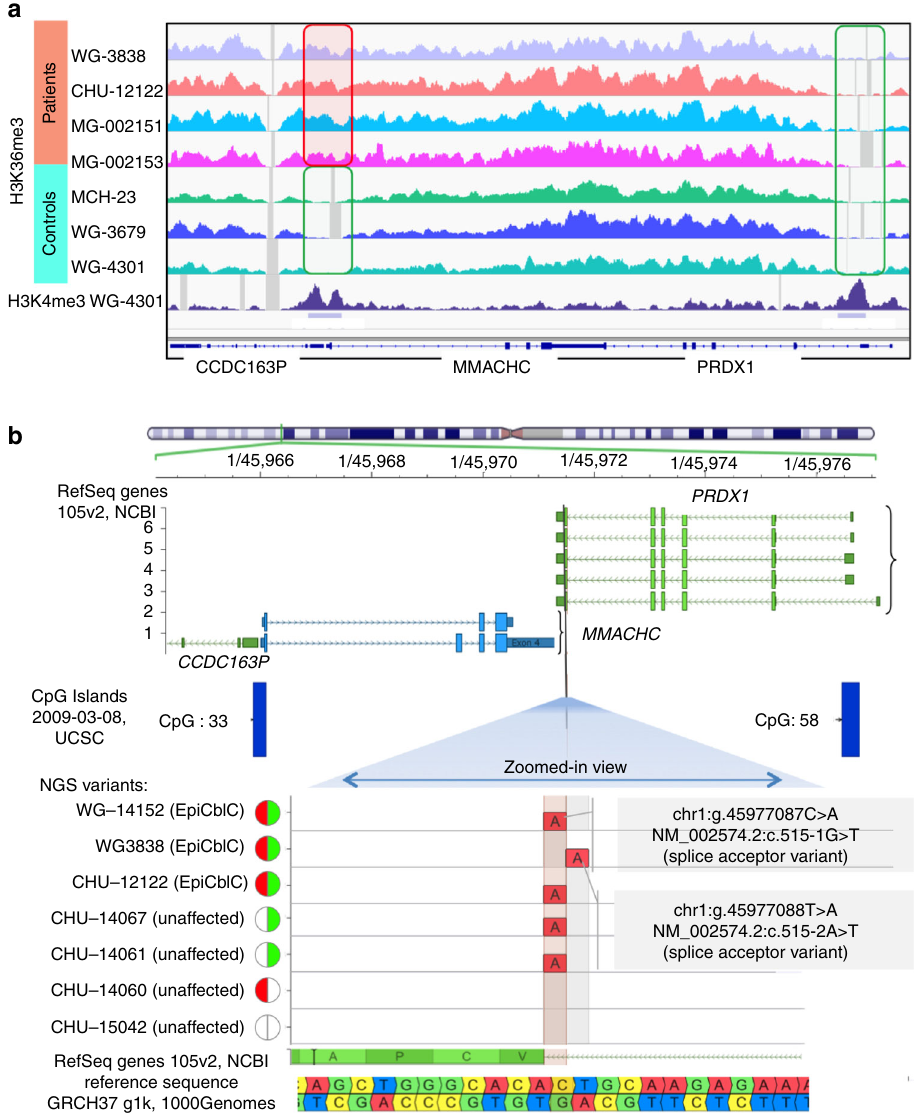
Fig. 4 The MMACHC epimutation is associated with a H3K36me3 chromatin mark in the promoter and a mutation in the PRDX1 adjacent gene. a Results of ChIP-Seq analyses at the genomic region encompassing the promoters of MMACHC/CCDC163P and PRDX1 . Genomic panels show normalized coverage for histone H3 trimethylated lysine 36 (H3K36me3) mark in patients (tracks 1 – 4 from top) and controls (tracks 5 – 7). H3K4me3 track along with the peak calls, for one of the controls, has also been shown. The rectangles indicate the promoter regions. The same scale has been set in all panels. See Methods for more details on samples and analysis. b Identi fi cation of PRDX1 splice acceptor variants in cases with MMACHC epimutation by whole-genome sequencing. Top: the vertical black line is positioned on the locus of the two PRDX1 variants within the splice acceptor site (AG sequence) on intron 5. Bottom: zoomed view centered on the splice acceptor site of PRDX1 intron 5. Genomic positions are reported according to the reference sequence GRCh37. The red semicircle denotes the presence of MMACHC genetic mutation. The green semicircle denotes the presence of MMACHC epimutation. The white semicircle denotes the absence of